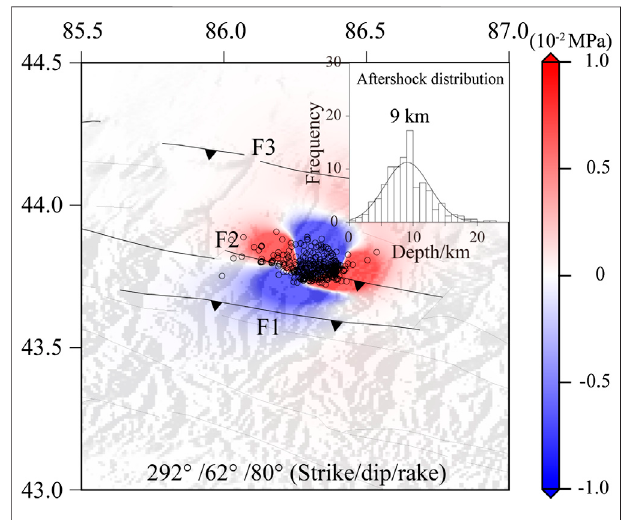
FIGURE 7 | Coseismic Coulomb stress change for the best- fi t source parameters of 292 ° /62 ° /80 ° (strike/dip/rake). The frictional coef fi cient is assumed tobe0.4(Kingetal.,1994).Faultlabelsarethesameasin Figure1